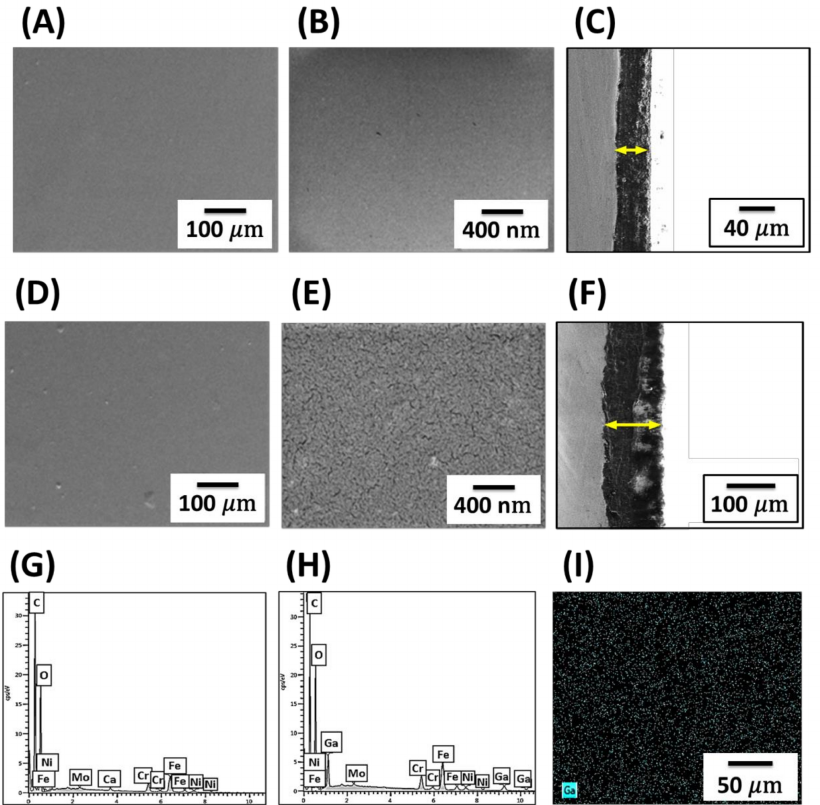
Figure 1. SEM micrographs of the surface of the ( A,B ) CS coating, ( D,E ) 1:4 Ga (III)-CS complex coating, and cross-section morphologies of the ( C ) CS coating and ( F ) 1:4 Ga (III)-CS complex coating. EDX spectra of the ( G ) CS coating, ( H ) 1:4 Ga (III)-CS complex coating, and ( I ) elemental EDX mapping of Ga for the 1:4 Ga (III)-CS complex